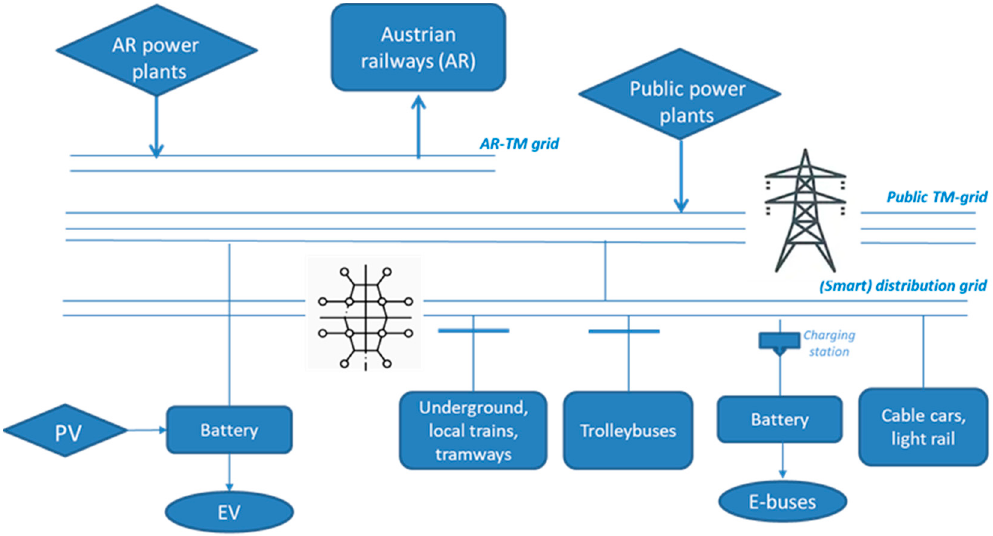
Figure 3. A stylized figure of how different modes and technologies of electric mobility are placed in the electricity system in the example of Austria.